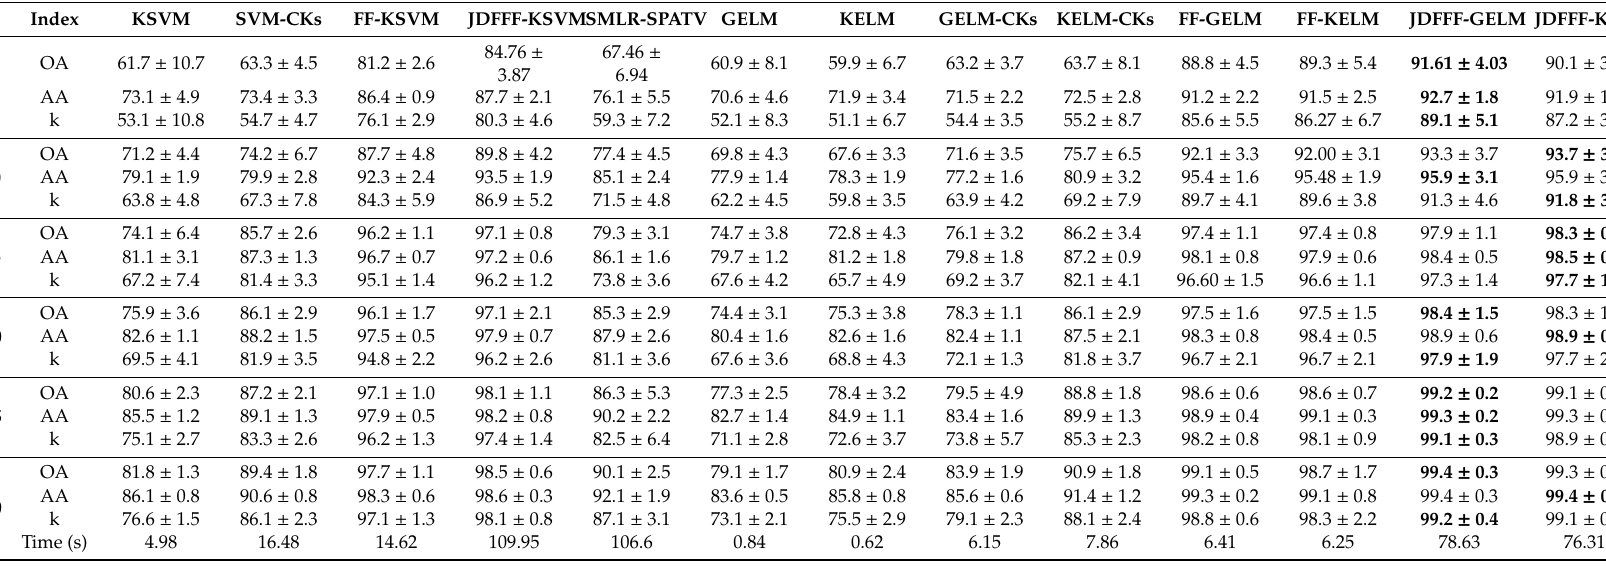
Table 5. Accuracy (%) with di ff erent numbers of labeled samples for the Pavia University dataset (the best result of each row is marked in